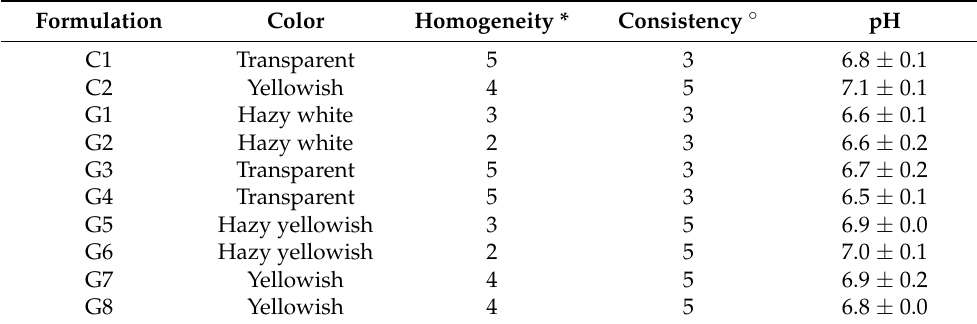
Table 1. Physical appearance and pH values of formulated hydrogels. Formulation Color Homogeneity * Consistency ◦ pH C1 Transparent 5